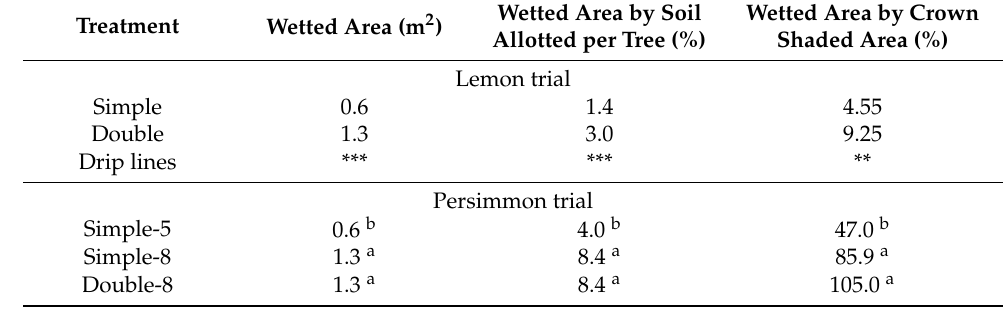
In the lemon trees trial, the tree water status was affected by the deficit irrigation regime, with trees under water restrictions reaching the minimum Ψ s in July, with values of −2.5 and −2.2 MPa in 2018 and 2019, respectively (Figure 1). The number of drip lines used for applying irrigation did not affect the tree water status.